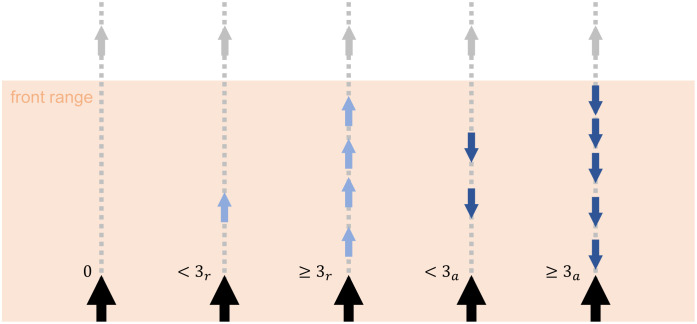
Graphical representation of the percepts’ meaning.Only the front visual range (colored region) is considered, which corresponds to the values that category sf can take. The focal agent is represented with a larger arrow than the frontal neighbors. The agent can only see its neighbors inside the visual range and it can distinguish if the majority are receding (light blue) or approaching (dark blue) and if they are less or more than three.